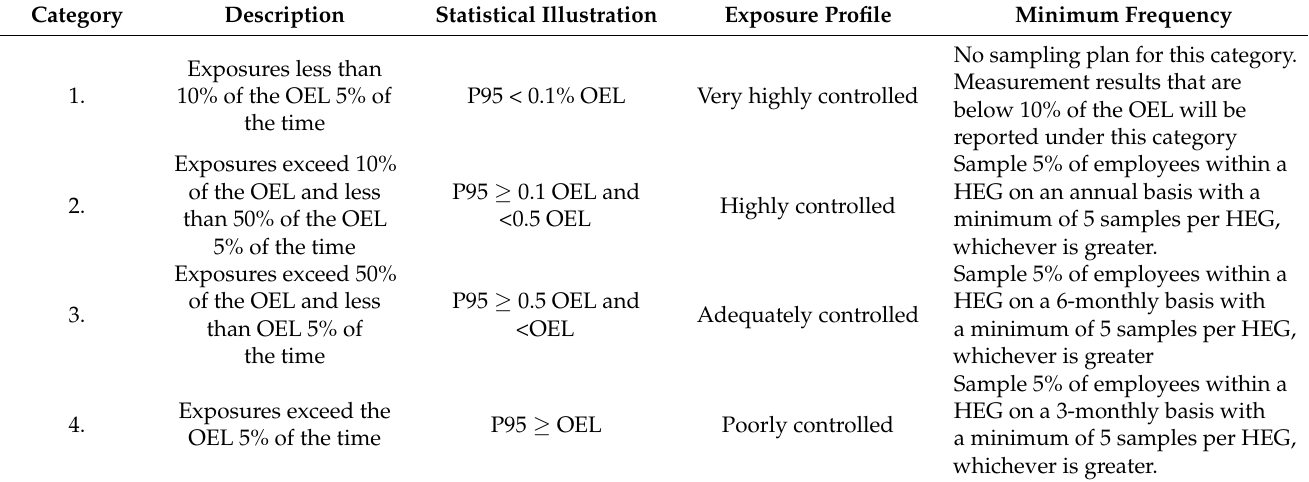
Table A1. The Exposure Control Categories for Classifying the P95 of Exposure Compared to the OEL and Sampling Strategy of HEGs (Job Titles) in the SAMI